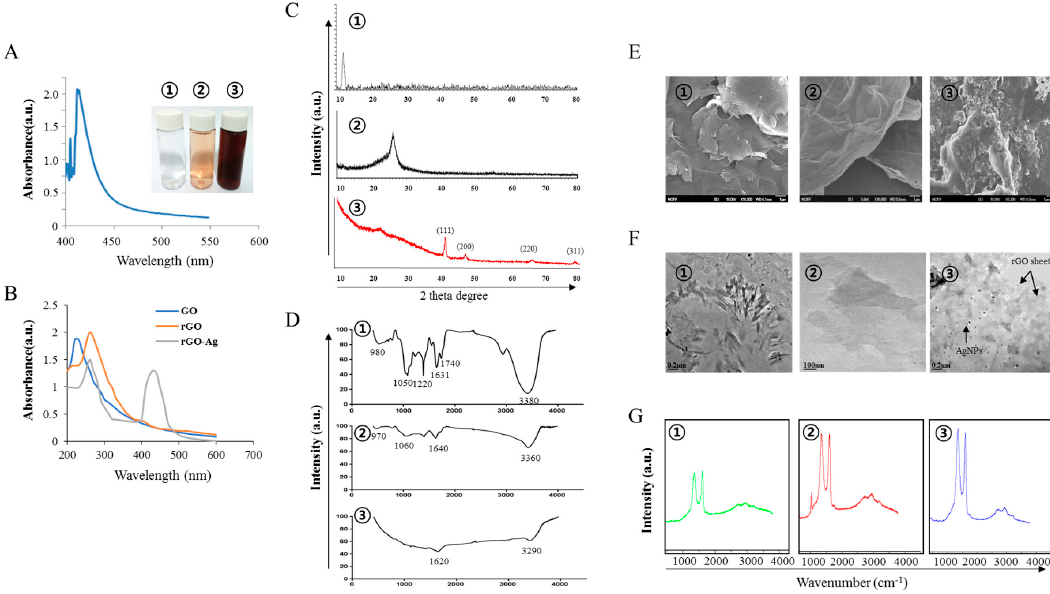
Figure 1. Synthesis and characterization of graphene oxide (GO), reduced graphene oxide (rGO), and rGO–Ag. ( A ) Synthesis of AgNPs using RPE. AgNPs exhibited a maximum absorption peak at ~430 nm corresponding to the surface plasmons and presence of AgNPs. The inset shows the tubes containing silver nitrate (1) RPE (2) silver nitrate and RPE (3); ( B ) Spectra of GO showed a maximum absorption peak at ~230 nm corresponding to the π – π transitions of aromatic C–C bonds. The inset shows color of GO (1), rGO (2), and rGO–Ag (3); ( C ) X-ray diffraction (XRD)pattern of GO (1), rGO (2), and rGO–Ag (3); ( D ) Fourier-transform infrared spectroscopy (FTIR) spectra of GO (1), rGO (2), and rGO–Ag (3); ( E ) SEM images of GO (1), rGO (2), and rGO–Ag (3); ( F ) Transmission electron microscopy (TEM) images of GO (1), rGO (2), and rGO–Ag (3); ( G ) Raman spectroscopy of GO (1), rGO (2),